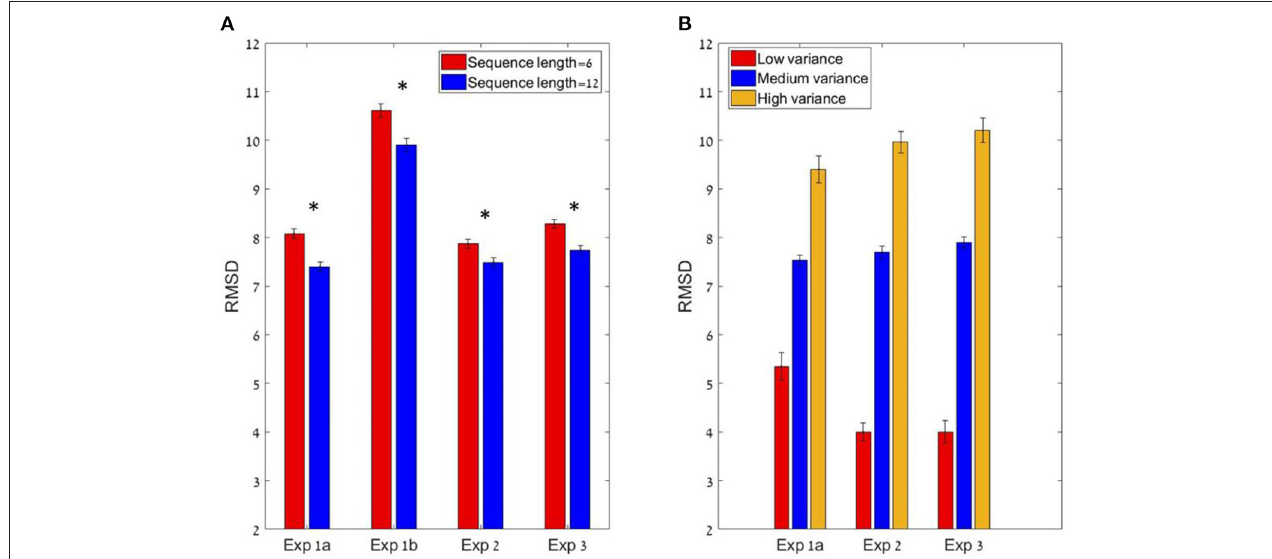
FIGURE 4 | (A) The sequence length effect for all four experiments (* corresponds to a statistically significant effect). In all experiments, the participants performed significantly better (lower RMSD) in the 12 items condition compared to the six items (at group level). (B) The Variance effect for all experiments (excluding 1b) which did not manipulated variance. All 3 experiments showed a linear trend in which precision decreases as variance